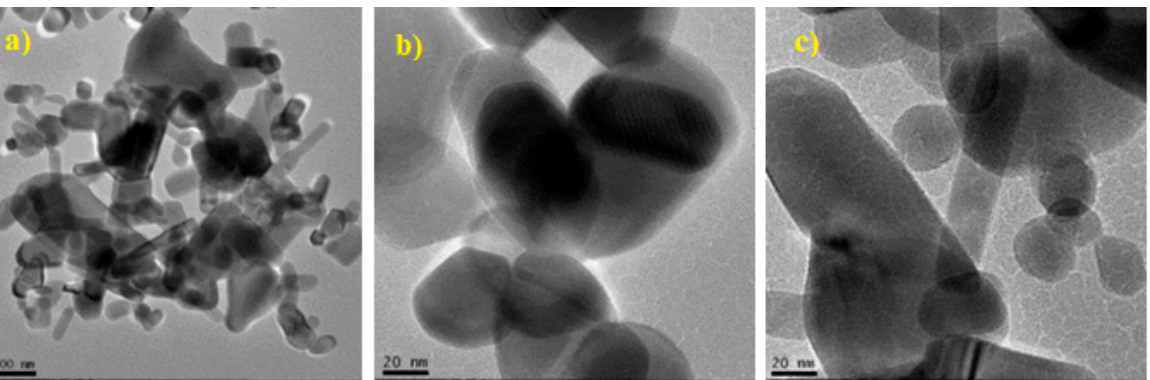
morphology were present among the ZnO nanoparticles’ structure.